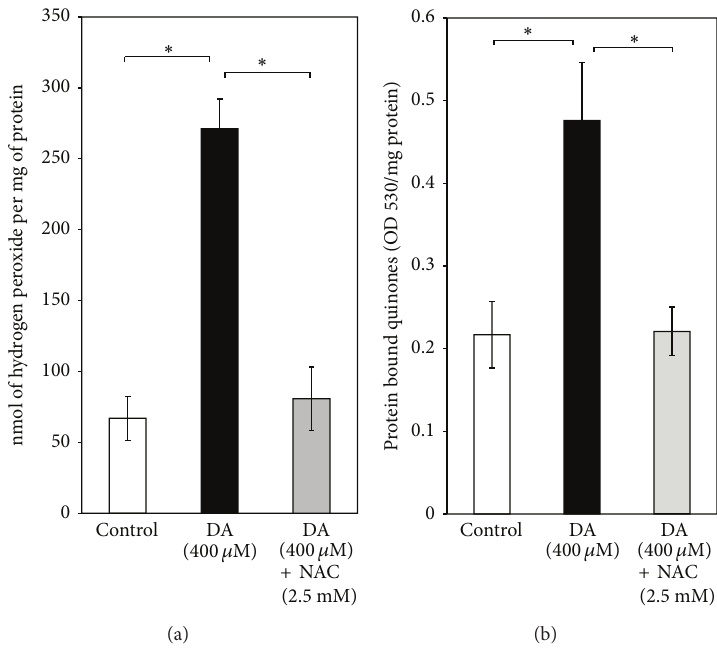
Figure3:Measurementofoxidativestressparameters.(a)EffectofNAC(2.5 mM)onDA(400 𝜇